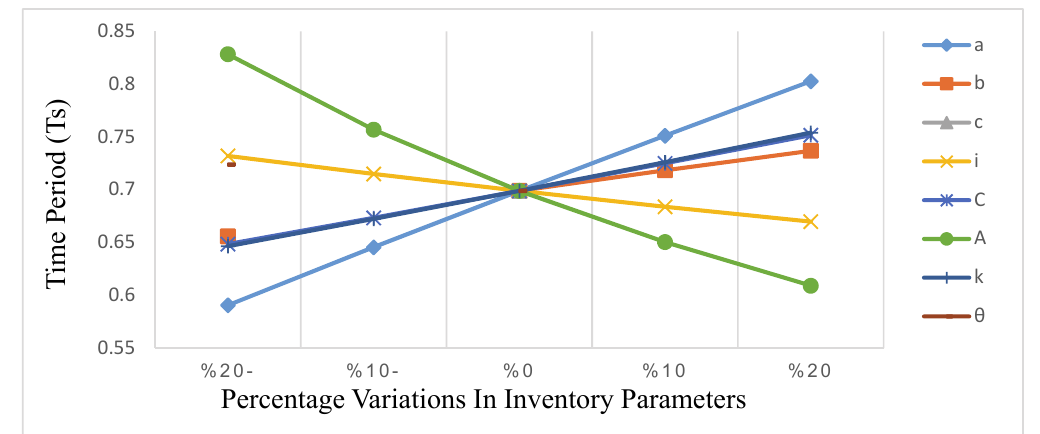
T w. r. t. inventory s